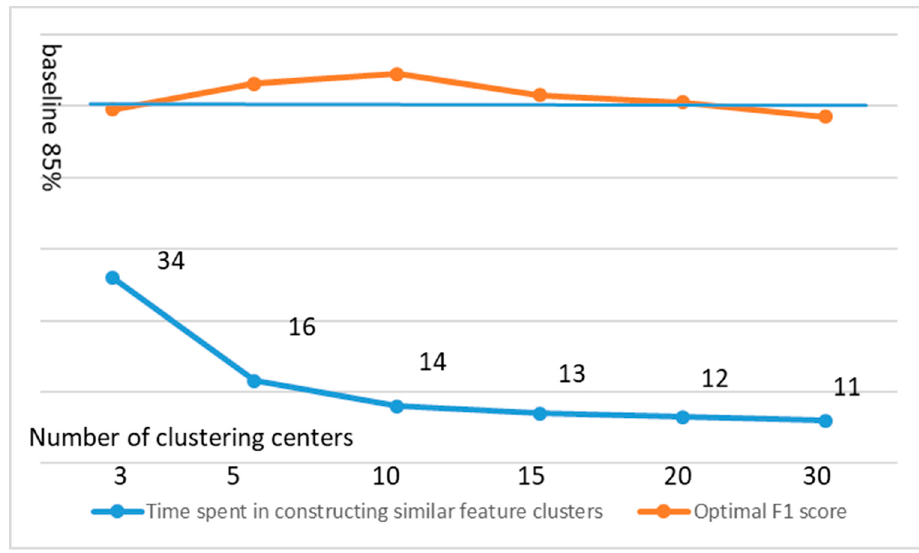
Figure 3. Spectral clustering results. The time refers to the cost of constructing similar feature clusters in minutes. The baseline for evaluating the F1 score is obtained using the TF-IDF